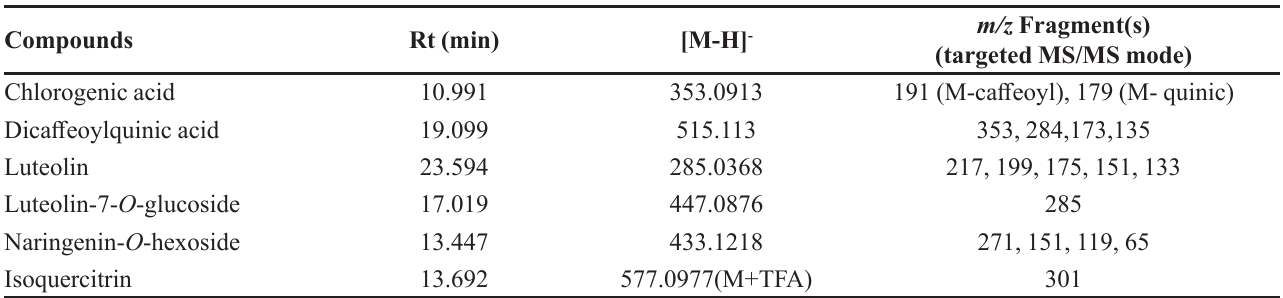
TABLE VII - Identification of phenolic compounds in H. plicatum subsp. plicatum